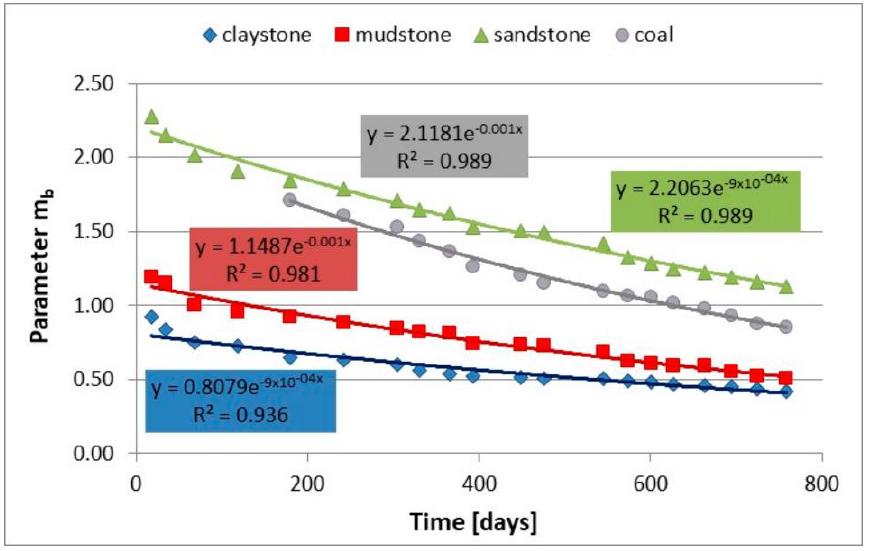
Figure 11. Changes in Hoek – Brown parameter m b for rocks around roadway D-2, chainage 595 m.